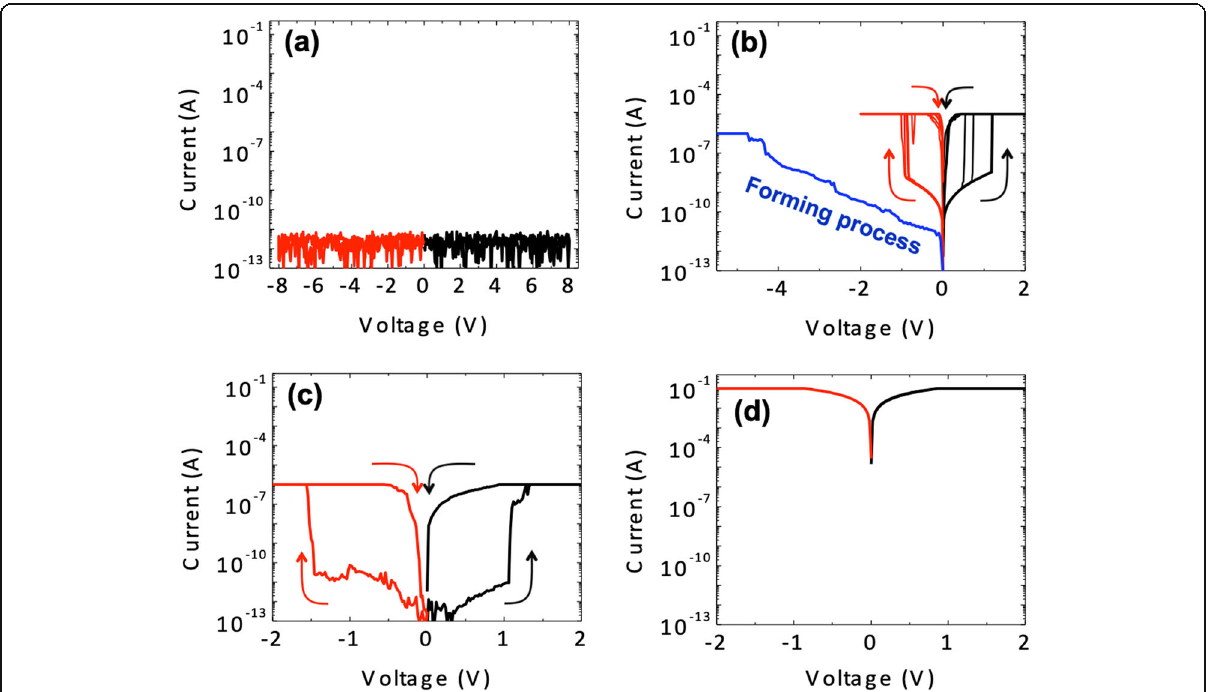
Fig. 2 Electrical properties of the fabricated devices. a I-V curve of D1 (highly insulating state). b I-V curve of D2, showing the EF process and subsequent TS behaviors. c I-V curve of D3, showing TS behavior without the EF process. d I-V curve of D4 (conducting